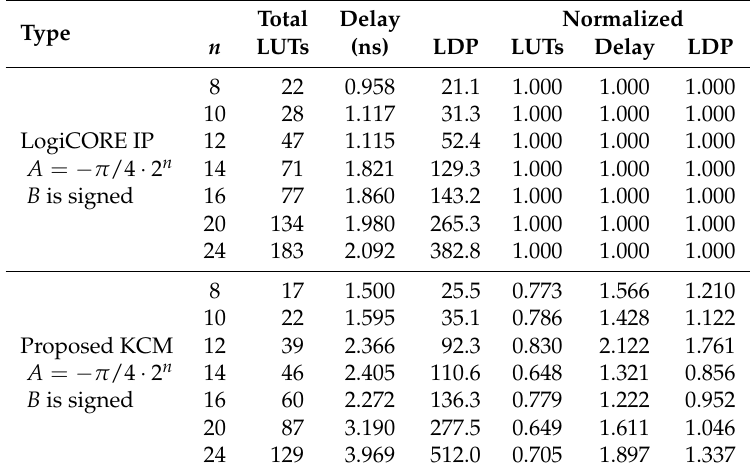
Table 4. Synthesis results for single-cycle ( m × n )-bit KCMs, where m = n , A = − π /4 · 2 n and B is a significant improvement compared to KCMs with a positive